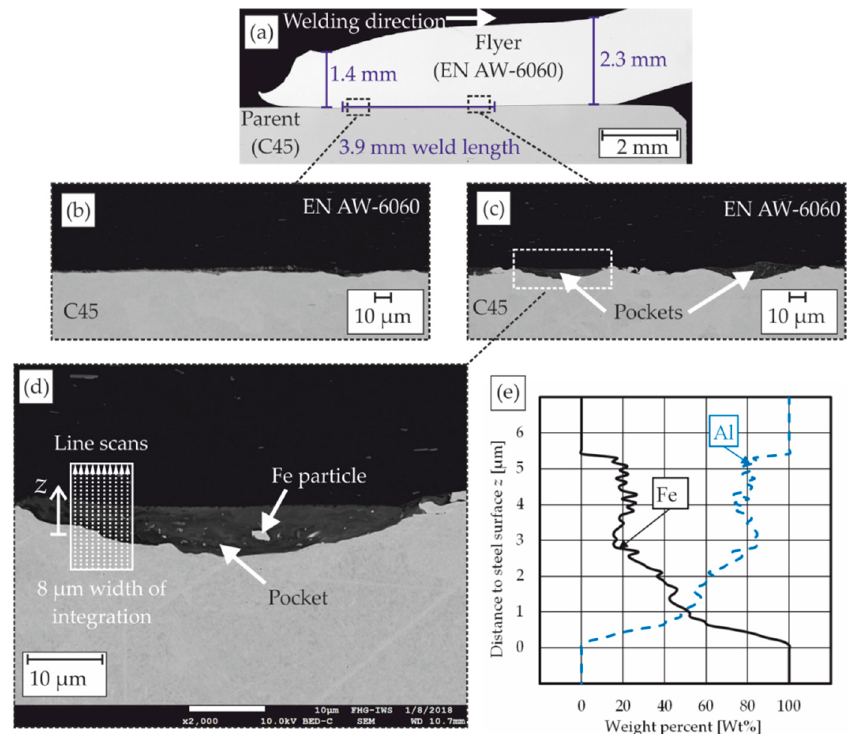
Figure 16. ( a ) Polished cross section of the joining zone after MPW at the Bmax setup ( l w = 6 mm, α = 0°, g = 1.5 mm, E = 8.0 kJ, I max = 503 kA, Ø coil = 41 mm, w c = 10 mm, flyer tube thickness s = 2 mm, flyer tube material in T66 condition), secondary electron image of the interface, ( b ) approximately 0.5 mm behind weld seam beginning with 500× magnification and approximately 3.5 mm behind weld seam beginning with ( c ) 500× magnification, ( d ) 2000× magnification and location of ten parallel line